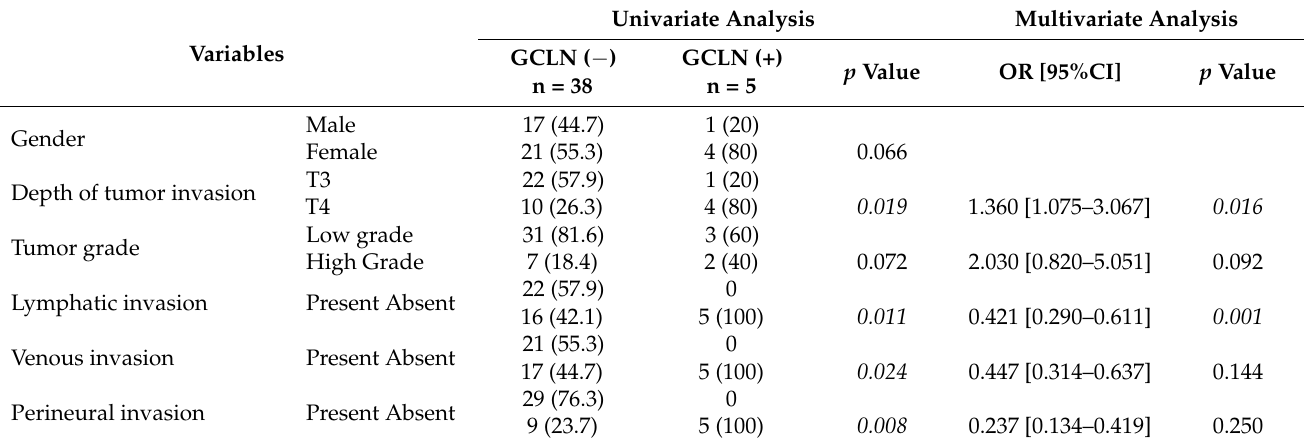
Table 4. Univariate and multivariate analysis for GCLN metastases.